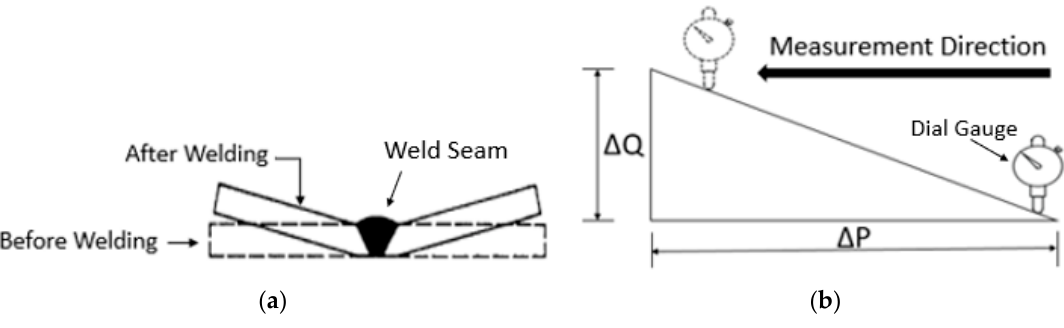
Figure 3. ( a ) Angular distortion; ( b ) Angular distortion measurement.